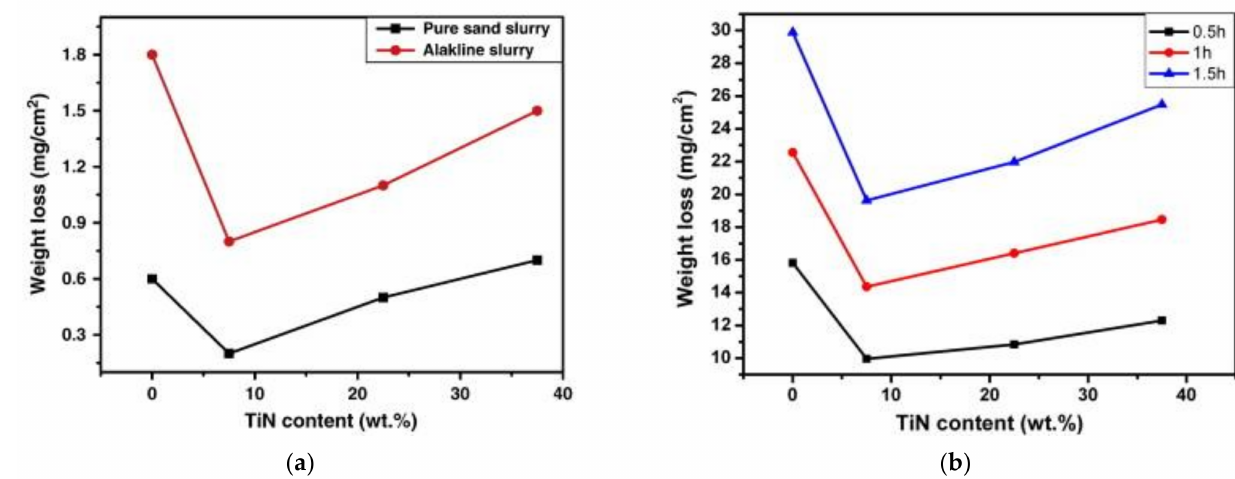
Figure 16. Weight loss of Ti(C,N)-15 wt% Ni cermets in different environments: ( a ) distilled water (neutral) and alkaline (5% NaOH) slurry, testing time 1 h [96]; ( b ) acid (0.5 mol/L H 2 SO 4 ) slurry